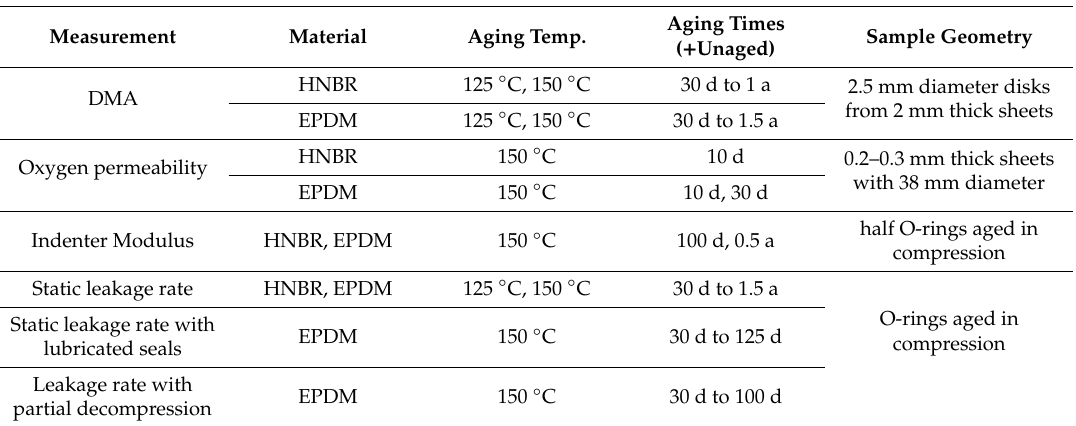
Table 2. Overview of experiments and samples.